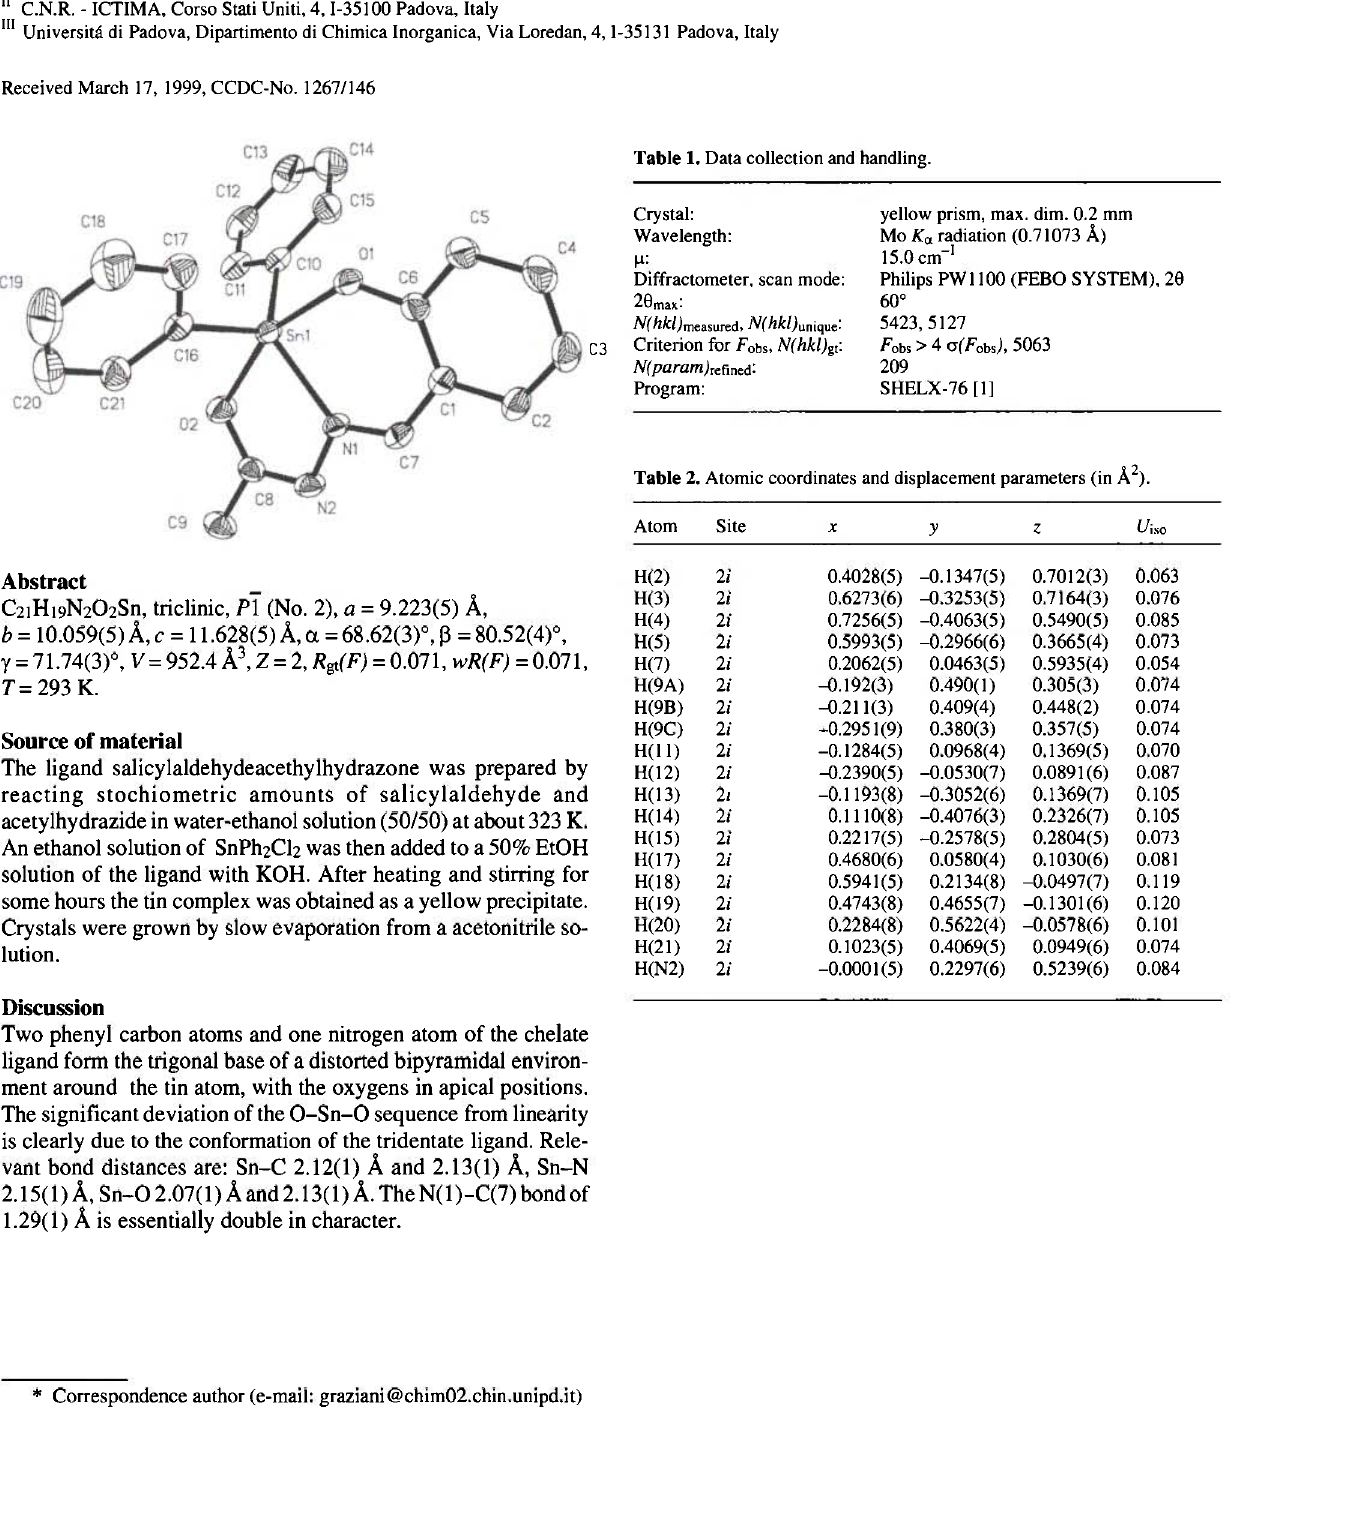
Table 2. Atomic coordinates and displacement parameters (in Ä 2